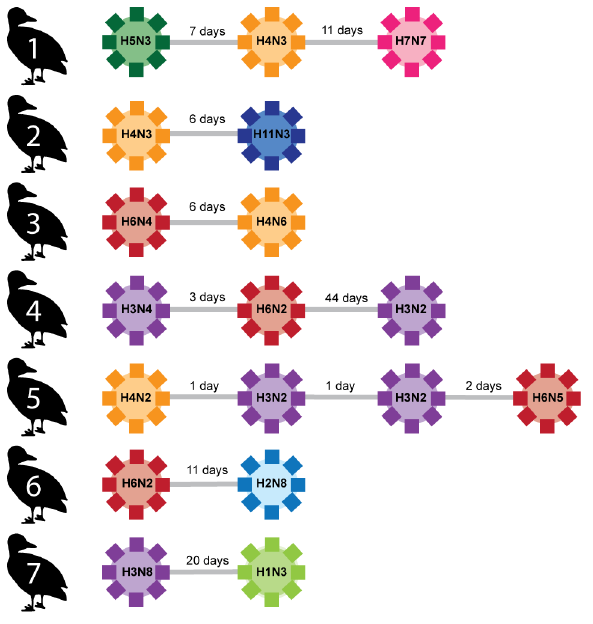
Figure 2. Examples of consecutive IAV infections in seven individuals. The subtypes of detected viruses, as well as time